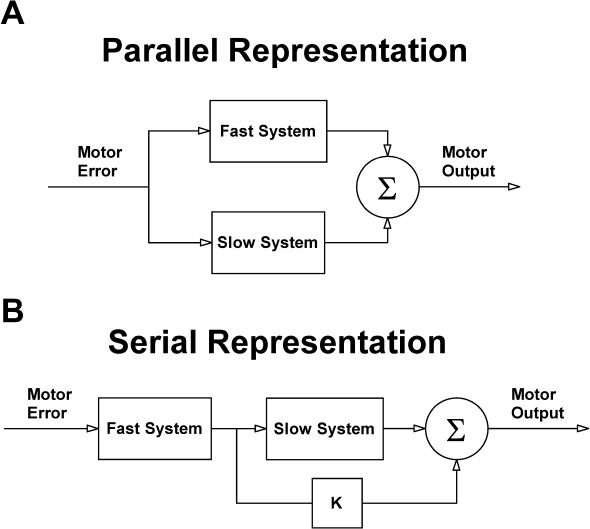
Two Different Internal Realizations of a Linear, Two-State, Multi-Rate SystemAny input-output behavior achieved by one realization can be duplicated by the other.